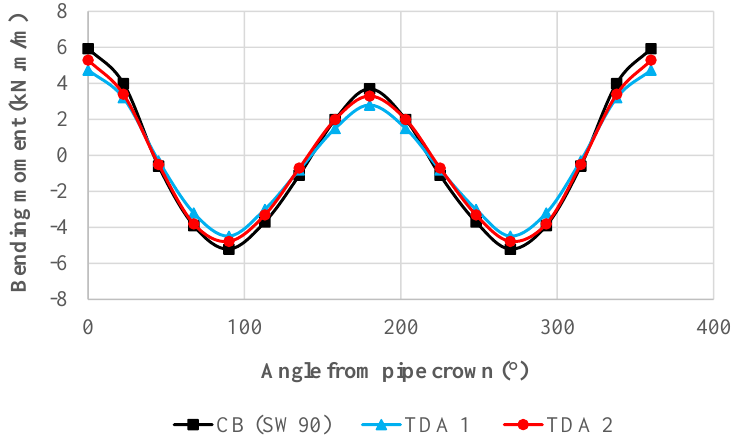
Figure 5. Comparison of the bending moment developed in the pipe wall for conventional backfill using SW90, TDA 1, and TDA 2 for SW90 backfill.